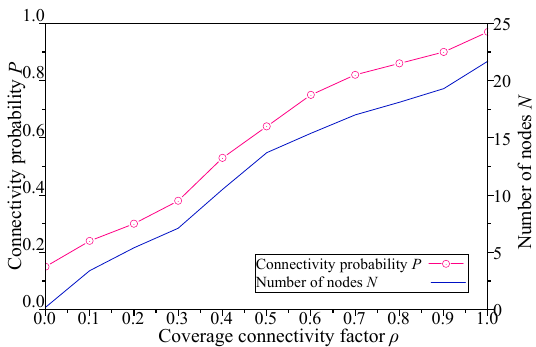
Figure 5. Influence of ρ on network connectivity probability and number of nodes.